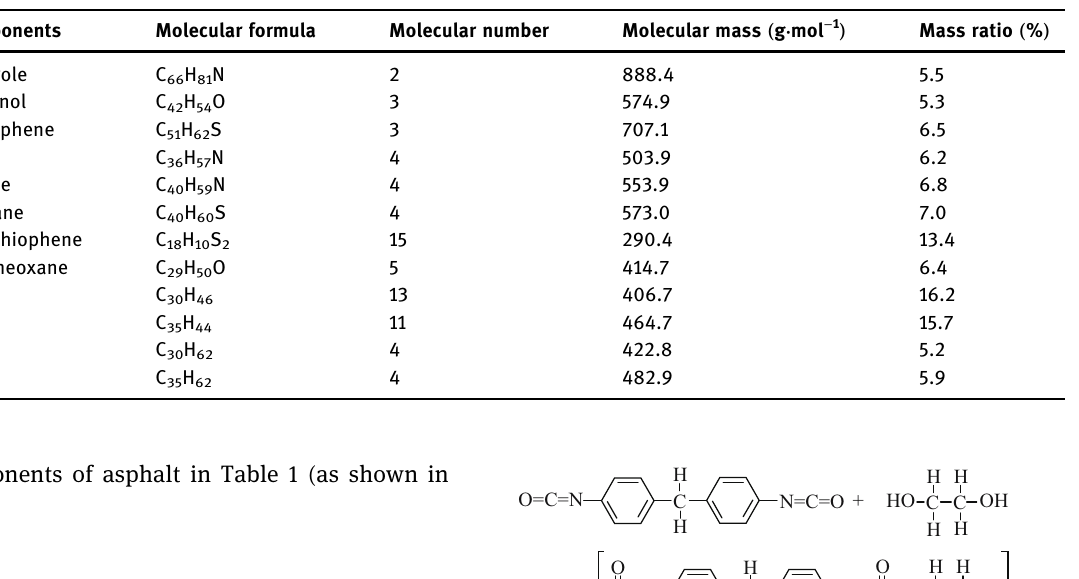
Table 1: Model composition of 12 components of asphalt